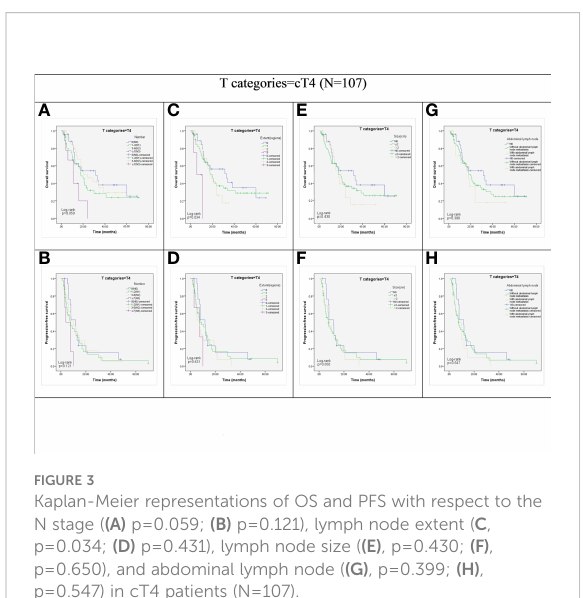
progression-free survival (PFS) in the cT4 group ( P = 0.431; Figure 3D).